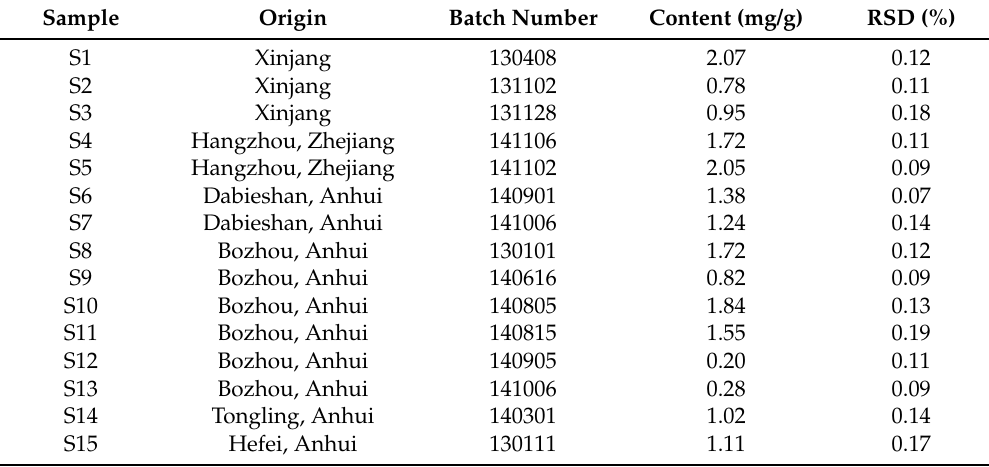
Table 3. Contents of DNJ in 29 batches of mulberry leaves samples ( n =